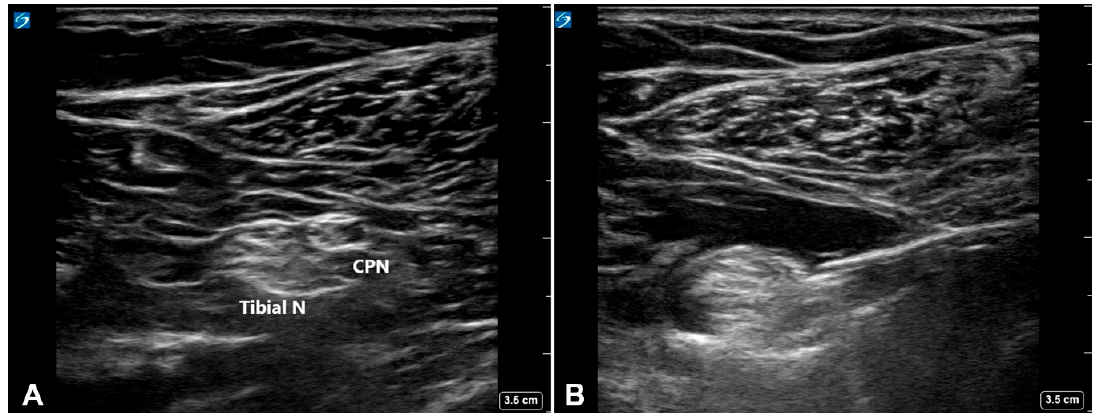
Figure 1. ( A ) Transverse ultrasound view of the sciatic nerve bifurcation in the popliteal fossa. ( B ) The needle tip located within the paraneural sheath.